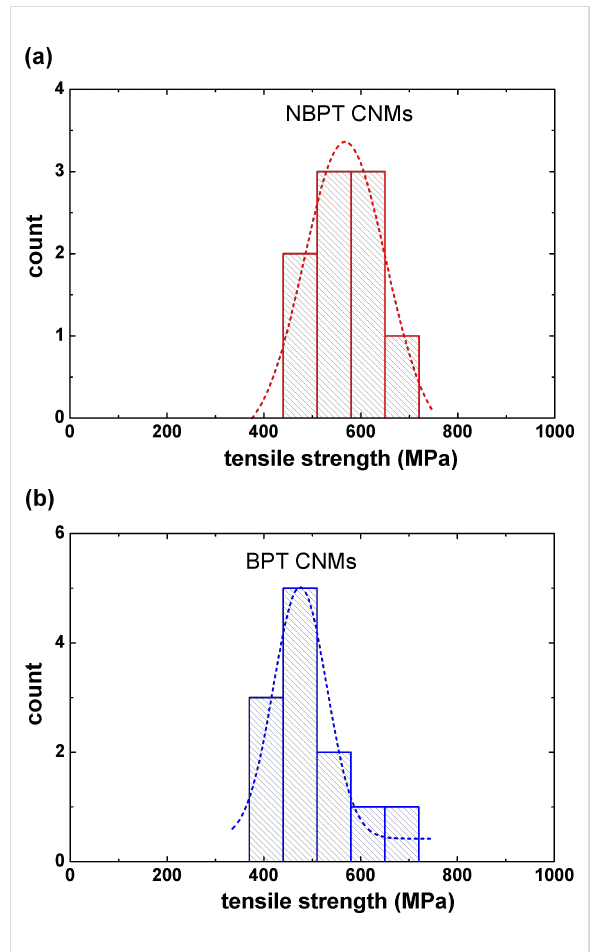
Figure 6: (a) Histogram of ultimate tensile strength of circular NBPT CNMs, with a peak at ~567 MPa (Gaussian peak fitting); (b) Histogram of ultimate tensile strength of circular BPT CNMs, with a peak at ~475